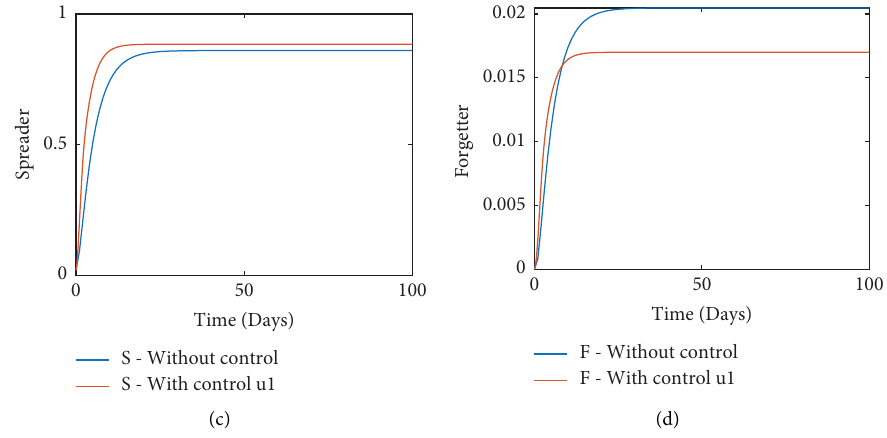
Figure 11: Comparison of population density with u